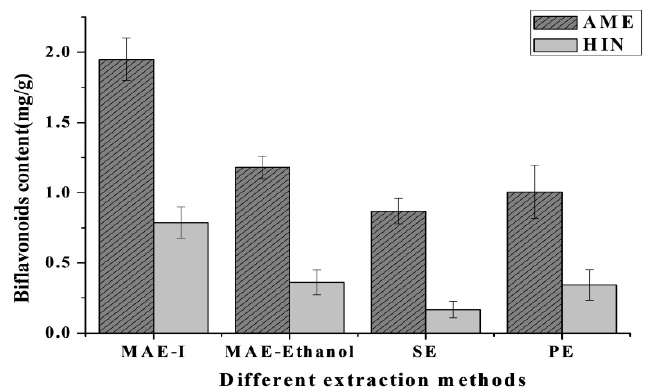
Figure 8. Comparison of different extractants in three conventional methods for extraction of AME and HIN from S. sinensis. ( A ) microwave extraction; ( B ) soxhlet extraction; ( C ) percolation extraction.